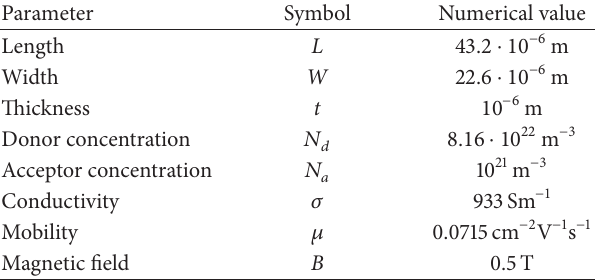
Table 2: Process 1 parameters.